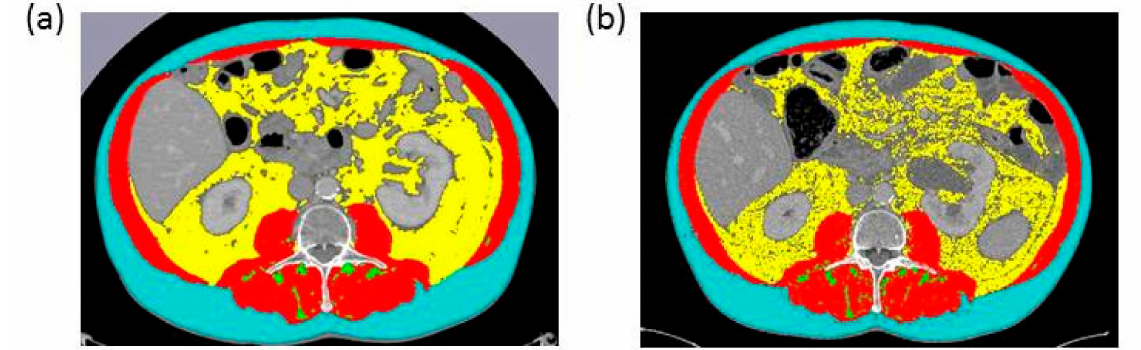
Figure 1. Axial CT images of the third lumbar vertebra region ( a ) before the initiation of FLOT chemotherapy and ( b ) after 4 cycles of FLOT chemotherapy in the same patient. In red, lumbar skeletal muscle area (SMA) (cm 2 ); in yellow, visceral adipose tissue area (VAT) (cm 2 ), in turquoise: subcutaneous adipose tissue area (SAT) (cm 2 ); in green, intramuscular adipose tissue area (IMAT) (cm 2